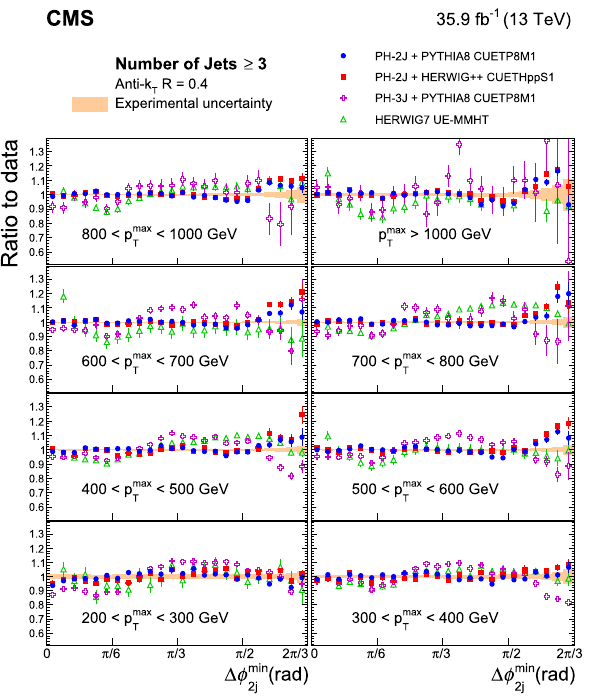
Fig. 14 Ratios of ph- 2j + pythia 8, ph- 2j + herwig++ , ph- 3j + Fig. 15 Ratios of ph- 2j + pythia 8, ph- 2j + herwig++ , ph- 3j + pythia 8, and herwig 7 predictions to the normalized inclusive 3-jet pythia 8, and herwig 7 predictions to the normalized inclusive 4-jet cross section differential in Δφ min , for all p max regions. The solid band cross section differential in Δφ min , for all p max regions. The solid band 2j T 2j T indicates the total experimental uncertainty and the vertical bars on the indicates the total experimental uncertainty and the vertical bars on the points represent the statistical uncertainties of the simulated data points represent the statistical uncertainties of the simulated data